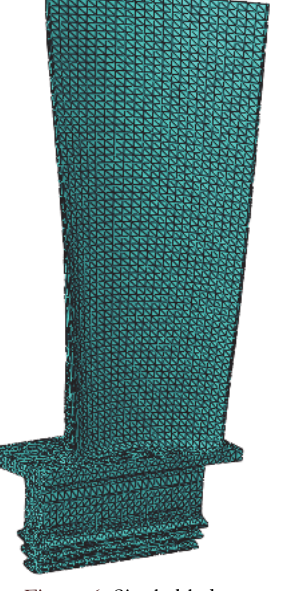
Figure 6: Single blade. Figure 7: Rotor